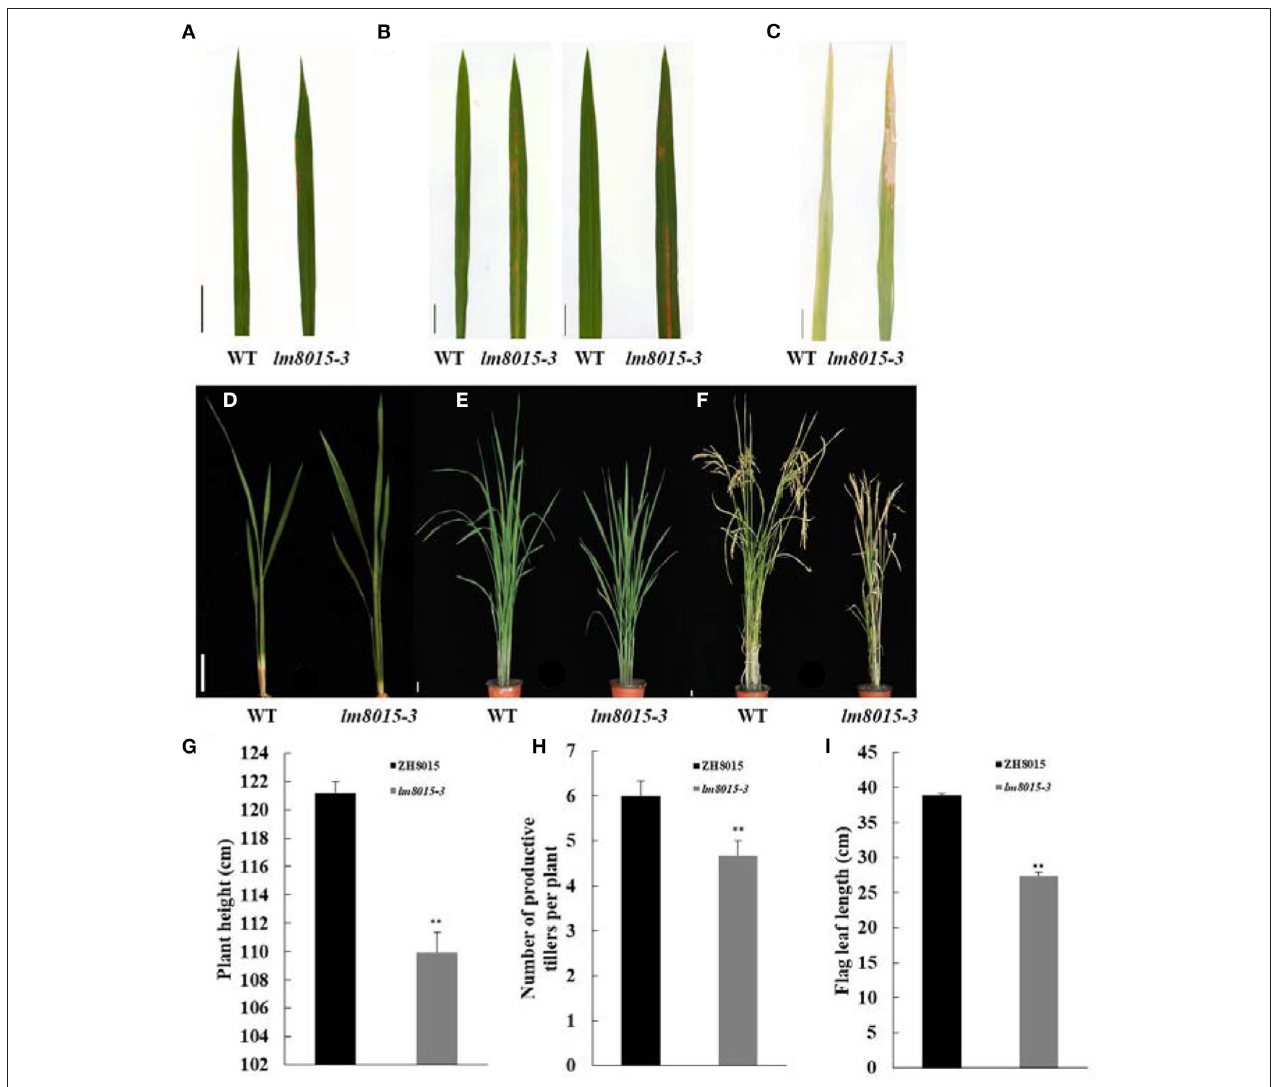
FIGURE 1 | Phenotypic characterization of the lm8015-3 mutant. (A–C) Leaf phenotypes of ZH8015 and lm8015-3 at the seedling stage, tillering stage, and mature stage. (D–F) Plant architecture of ZH8015 and lm8015-3 at the seedling stage, tillering stage, and mature stage. Scale bar = 2cm. (G–I) Bar graphs of plant height, number of productive tillers per plant, and flag leaf lengths of ZH8015 and lm8015-3 measured at the mature stage. **Significant at P < 0.01 ( t -test); Error bars represent SD ( n =